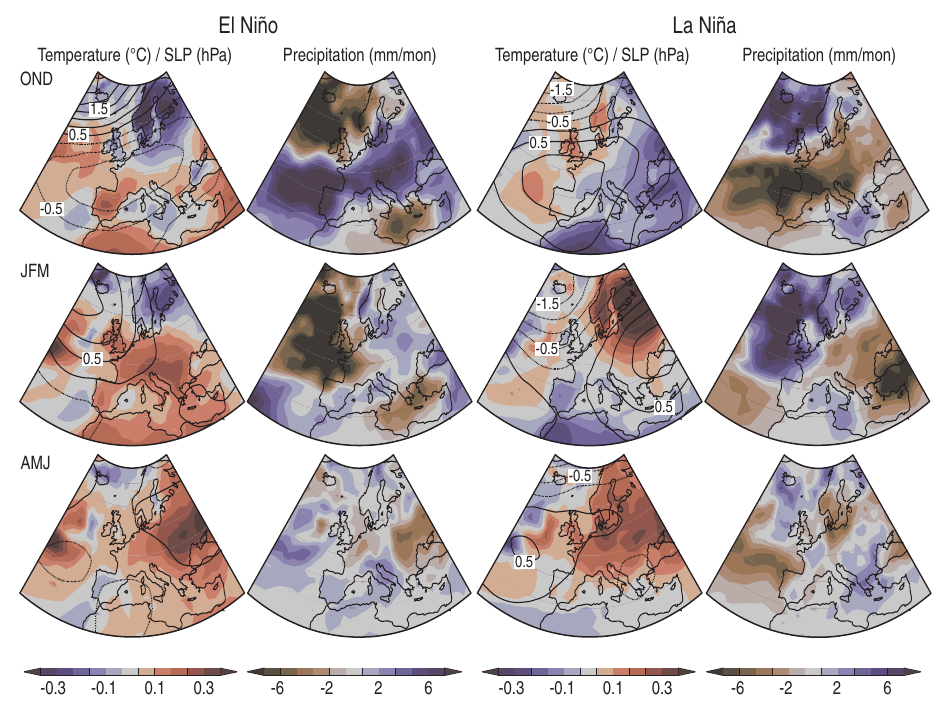
Fig. 4. Anomaly fields of temperature, SLP (contours), and precipitation for strong El Nino and strong La Nina events in 540 years of the control run b30.009 of version 3 of the Community Climate System Model (CCSM3) for different seasons. Strong events are defined when the September-to-February average of Nino3.4 index was outside 1 standard deviation. In the precipitation maps blue corresponds to above normal precipitations and brown to below normal precipitation. In the temperature maps blue indicates below normal values and red above normal values. Consistent with observations, this simulation suggests that by and large the area surrounding Crete will experience drier and warmer conditions during El Nino (from Bronnimann, 2007; Figure courtesy of Stefan Bronnimann).